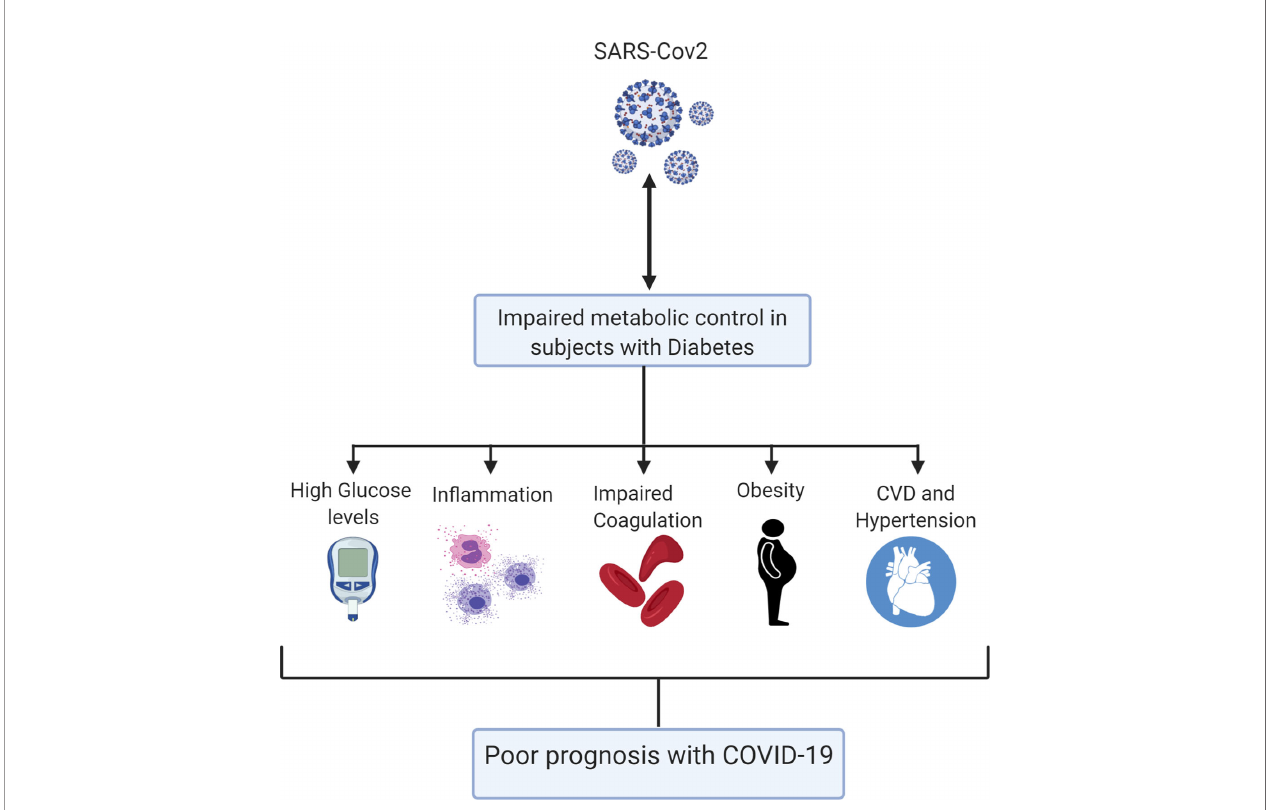
FIGURE 1 | A schematic model summarizing the various mechanisms by which diabetes can impact on COVID-19 poor